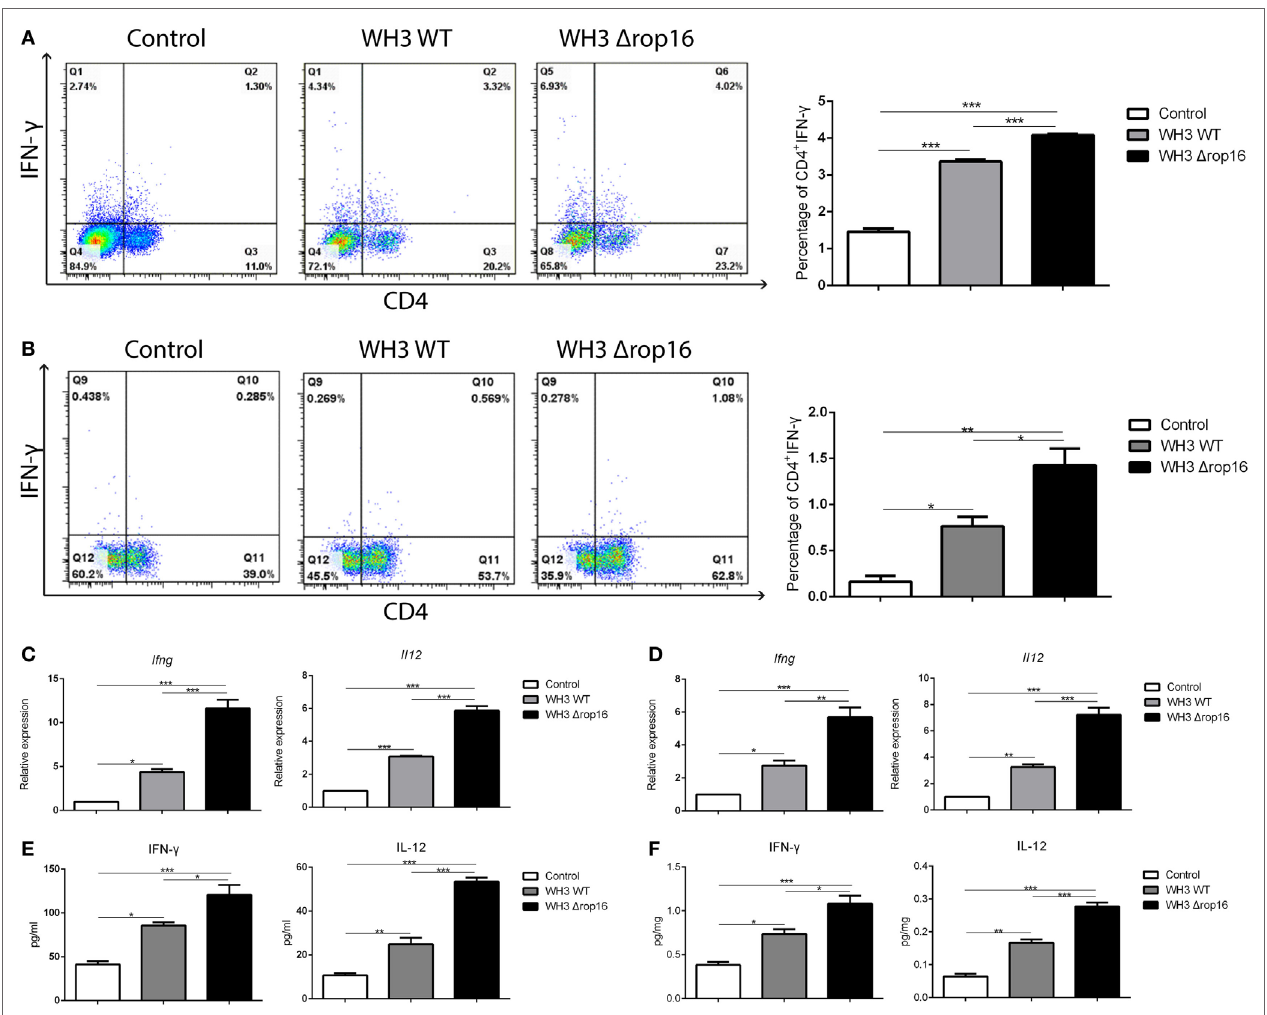
FigUre 4 | WH3 Δ rop16 strain infection upregulated Th1 response of pregnant mice. Increased percentage of Th1 (CD4 + IFN γ + ) cell population in the spleens (a) and placentas (B) of WH3 Δ rop16 tachyzoites compared to the control. The relative mRNA expressions of interferon (IFN)- γ and interleukin (IL)-12 were sharply increased in the spleens (c) of WH3 Δ rop16 -infected mice and placentas (D) . The supernatants were tested for IFN- γ and IL-12 in the spleens (pg/ml) (e) and placentas (pg/mg) (F) by enzyme-linked immunosorbent assay (* p < 0.05, ** p < 0.01, *** p <